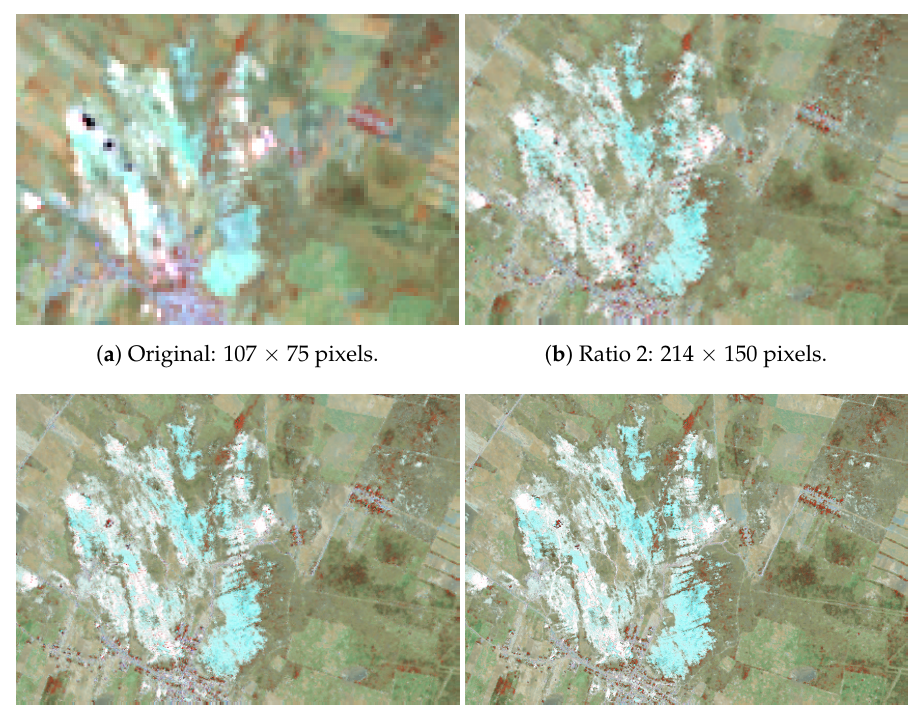
Figure 12. Training statistics for Landsat 8 and Google Earth images with 30 m spatial resolution.